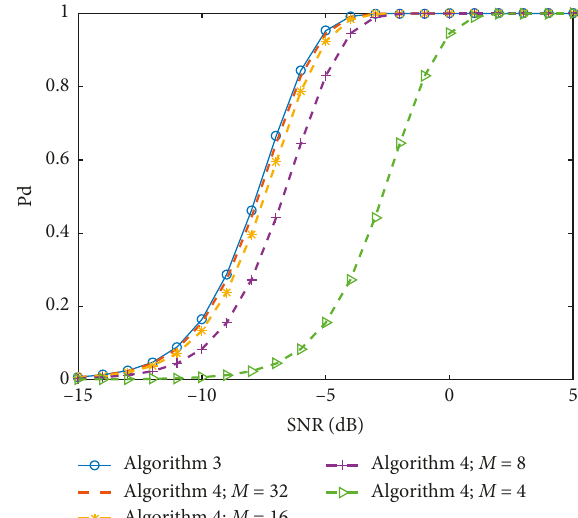
Figure 9: Detection probability versus SCNR. Algorithm 4: dashed curves. Algorithm 3: o-marked